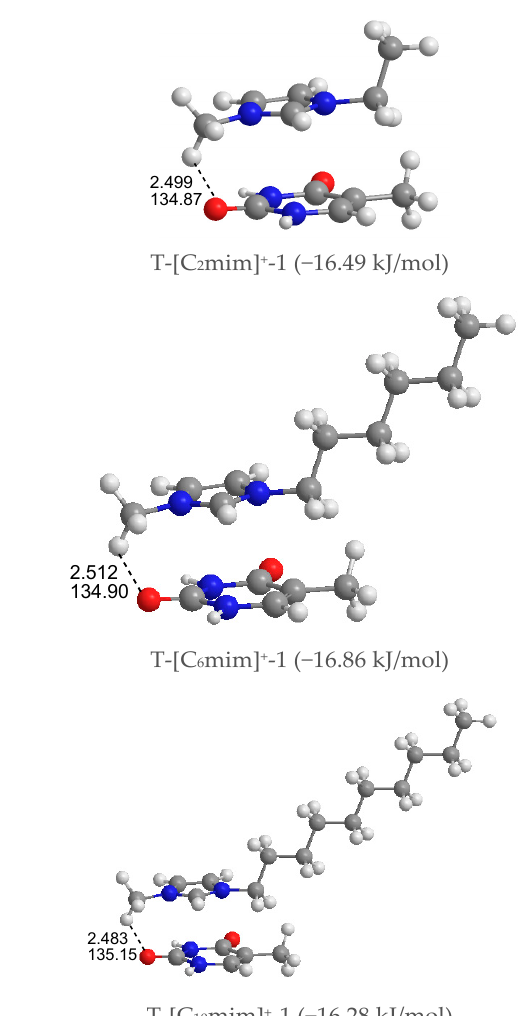
Figure 2. The most stable structures for the mono-ionic thymine, T-Br − -1 and T-[C n mim] + -1 ( n = 2, 4, 6, 8, 10). The bond length in Å, H-bond angle in °, binding energy listed in parentheses. In common with the T-[C n mim] + system, as shown in Table S2, the second most stable configuration is a perpendicular structure (T-[C n mim] + -Br − -5), where the Br − anion allows itself on top of the imidazolium cations and forms N1-H···Br − HB with thymine, and the [C n mim] + cations form double + C(2)-H···O7 and + C(6)-H···O7 HBs with thymine in an edge-to-face manner—adding an anion and leading to a greater stabilization T-[C n mim] + -Br − -1, which are differing from T-[C n mim] + -1 complexes in the position of the HB binding sites between the base and cations, occupying the “sugar edge” site [78] (i.e., N1-H and C2=O7 sites) of thymine. It is also the case for the less stable and coplanar geometries (T-[C n mim] + -Br − -9), which are reminiscent of the copla- nar HBs in the A-T base pair involving the “Watson-Crick” site (i.e., N3-H and C4=O8 sites) [79]. As we know from an MD simulation [42], the stabilities of A-T and G-C base pairs in the hydrated ILs are reversed under the premise that the ions do not in- teract with the HB-forming atoms of A-T pairwise. Compared with the absolute E B values, we have found that the superiority of T-[C 6 mim] + -Br − -5 in the perpendicular complexes (50.46 > 49.37 < 50.54 > 49.90 > 48.95 kJ/mol), while the slight distinctiveness of T-[C 8 mim] + -Br − -9 in the coplanar series (46.33 > 47.55 < 48.54 < 48.96 > 47.75 kJ/mol). From the E B vales, to T-[C n mim] + -Br − -1, 5, 9 complexes, the stable order is stacking > perpendicular > co-planar.3.1.4. Tri-ionic T-[C n mim] + -2Br −